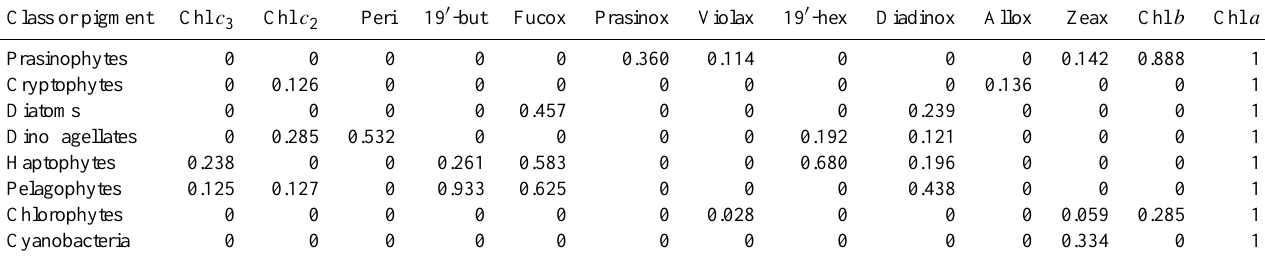
Table 3. Biomarker pigment initial ratio matrix for CHEMTAX: chl a ratios for eight algal groups. Class or pigment